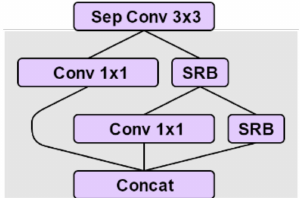
Figure 2. FDB (feature distillation block).